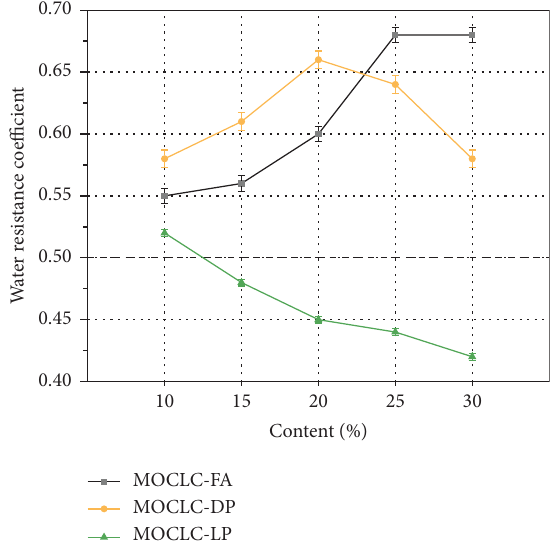
Figure 9: Water resistance coefcient of MOCLC varies with the type and content of mineral